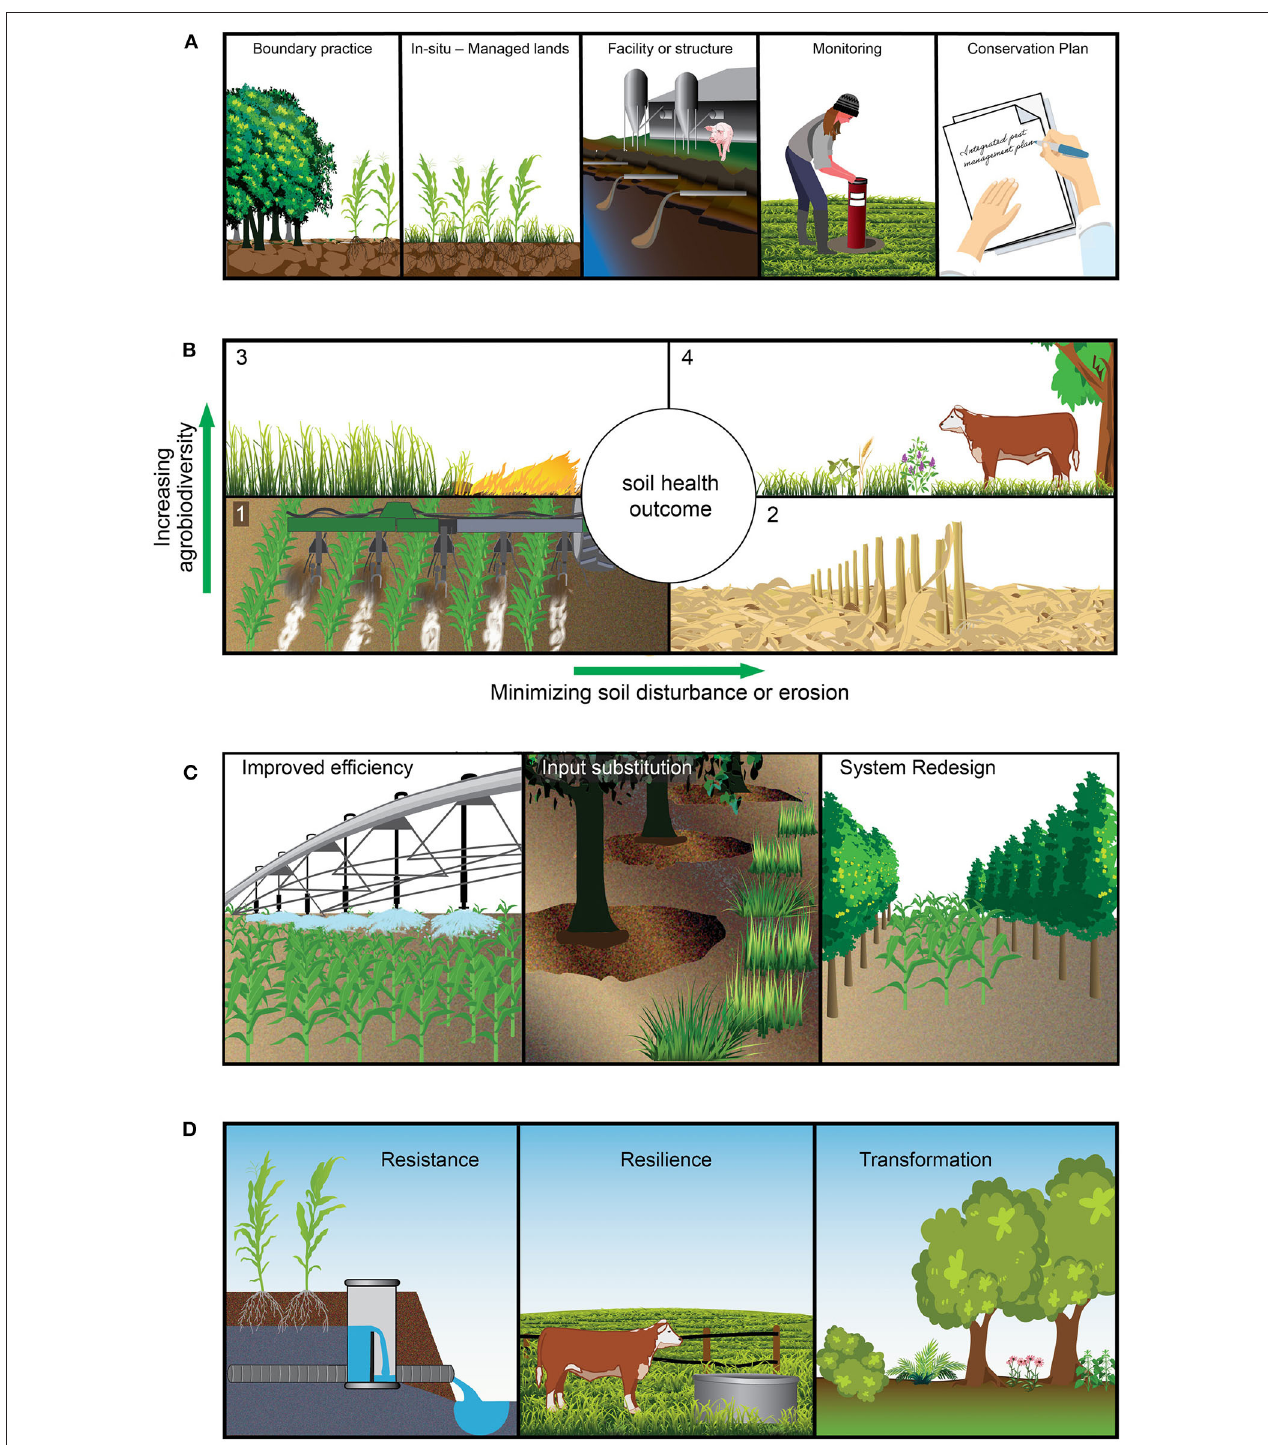
FIGURE 1 | Representations of practices and the various categories included in this analysis. USDA NRCS National Conservation Practice Standards code numbers are included below in parenthesis and can be found at the Standards Catalog Website (USDA-NRCS, 2020b). (A) illustrates the categories within the “type” classification, including: boundary practices, represented by Windbreak/Shelterbelt Establishment (380); managed lands, represented by Cover Crop (340); facility or structure, represented by Waste Storage Facility (313); monitoring, represented by Groundwater Testing (355); and conservation plan, represented by IPM Herbicide Resistance Weed Conservation Plan - Written (154). (B) illustrates the categories within the “soil health outcome” classification, including: Quadrant 1 , no change or